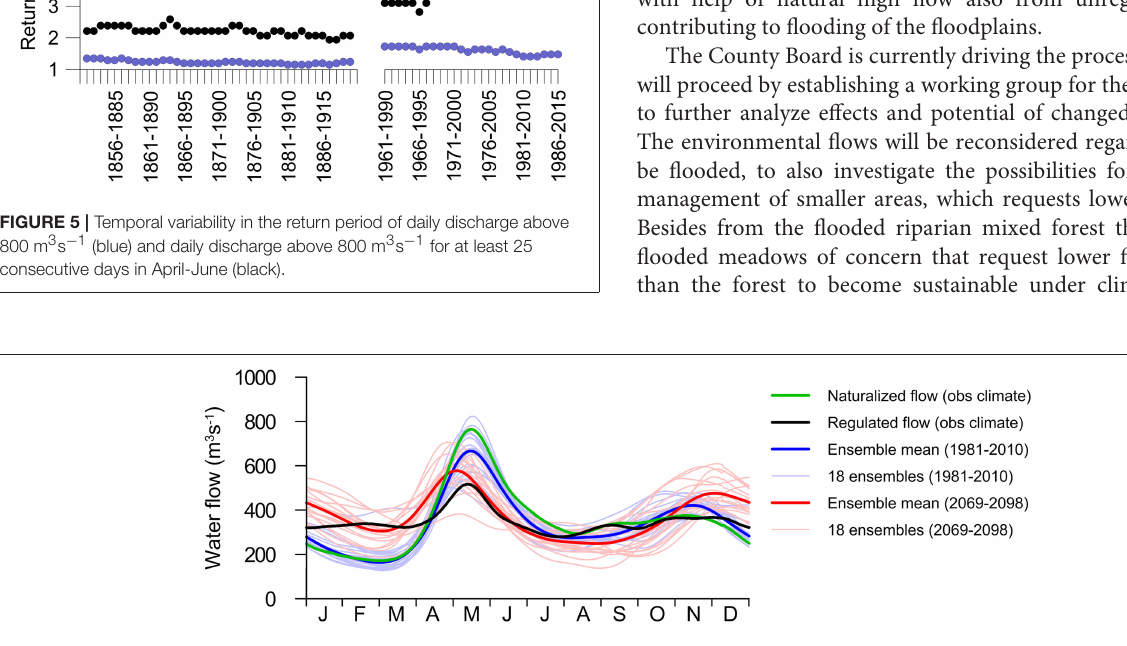
Frontiers in Environmental Science |